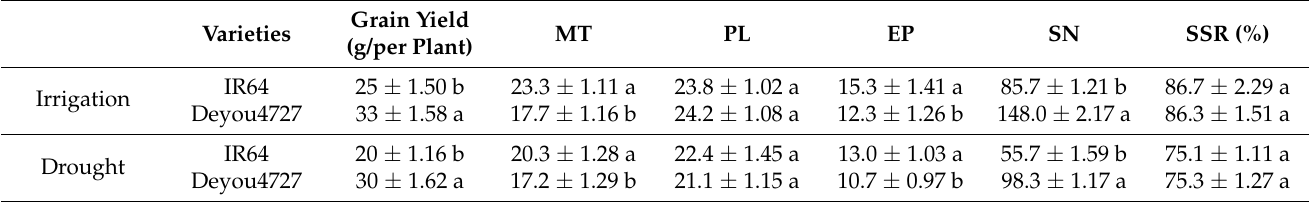
Table 1. The response of yield and the yield components of IR64 and Deyou4727 under irrigation and drought